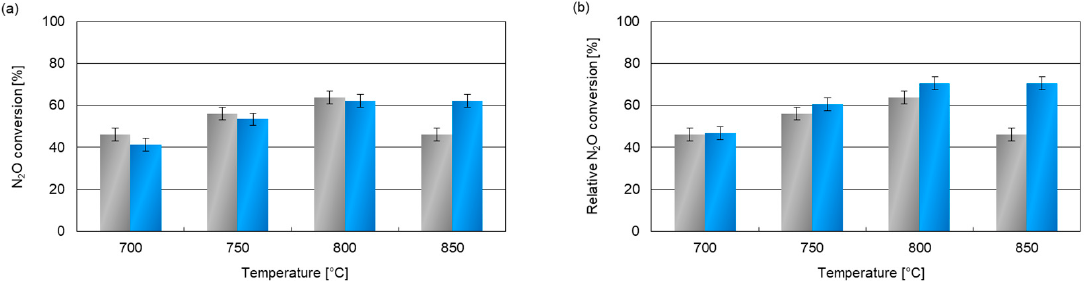
Figure 4. Nitrous oxide conversions in a stream composed of 5% N 2 O in Ar on the Co3.5La system (blue columns) and the undoped cobalt catalyst (grey columns): ( a ) conversion without accounting for difference in mass of Co 3 O 4 in catalyst bed, ( b ) conversion relative to the mass percentage of Co 3 O 4 in fresh catalyst bed.